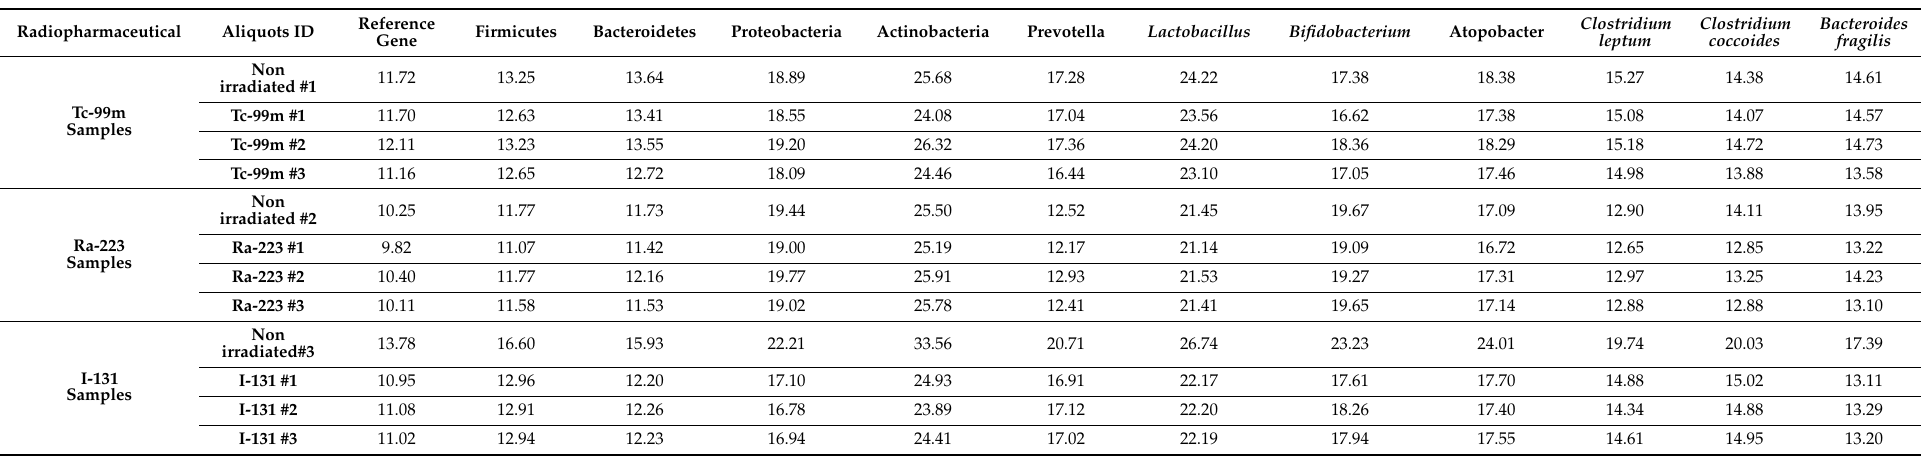
Table 1. Cycle threshold data from each sample (#-sample